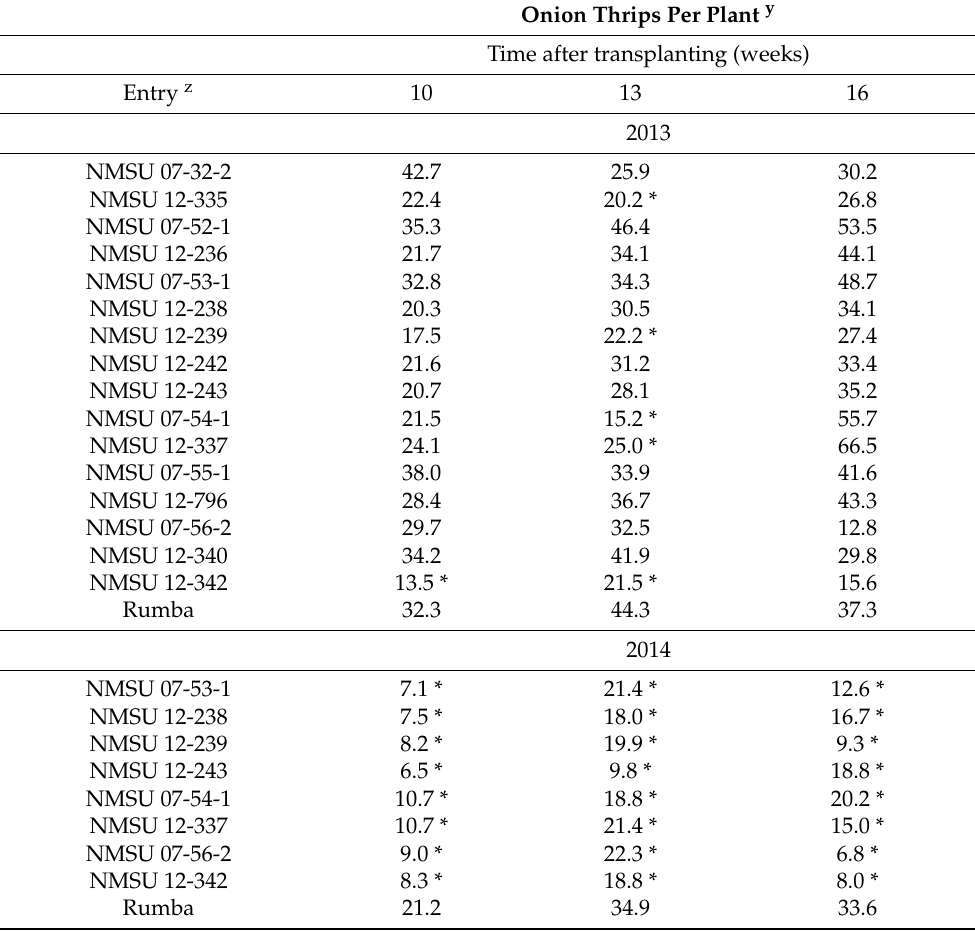
Table 2. Mean values and comparisons of selected lines with original populations and susceptible check ‘Rumba’ for thrips number per plant in the 2013 and 2014 growing seasons at the Leyendecker Plant Science Research Center in Las Cruces, New Mexico,